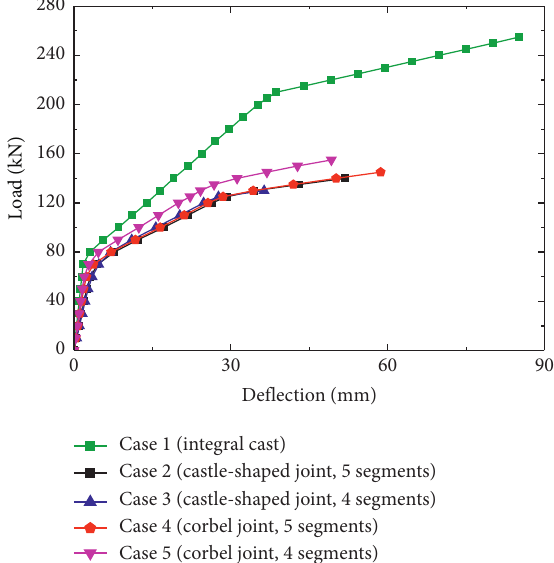
Figure 20: Load-deflection curves of cases 1 to